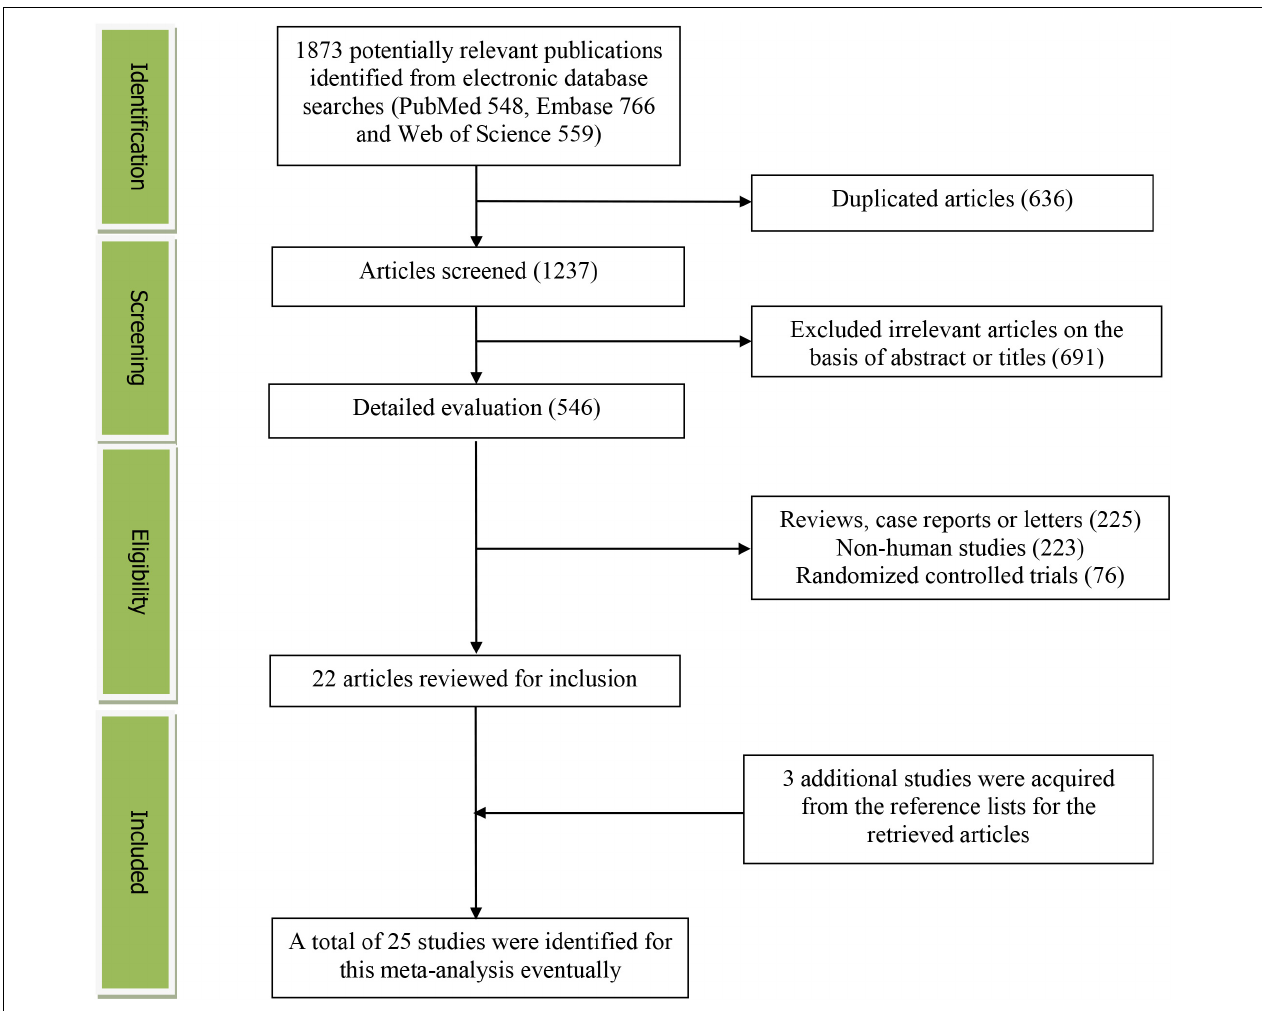
FIGURE 1 | The detailed flow diagram of the study identification and selection in this